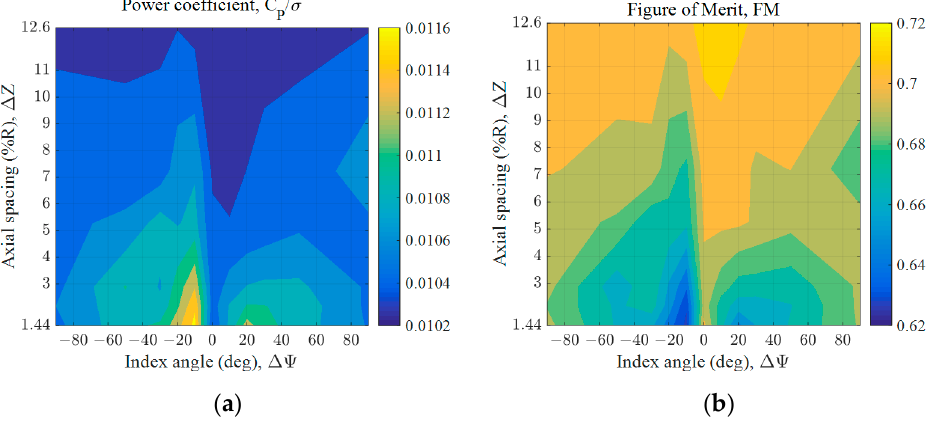
Figure 18. Hover performance analyses with respect to various index angles and axial spacings with built-in twist angle = − 12° ( C T = 0.0102): ( a ) Power ( C P / σ ); ( b ) Figure of Merit